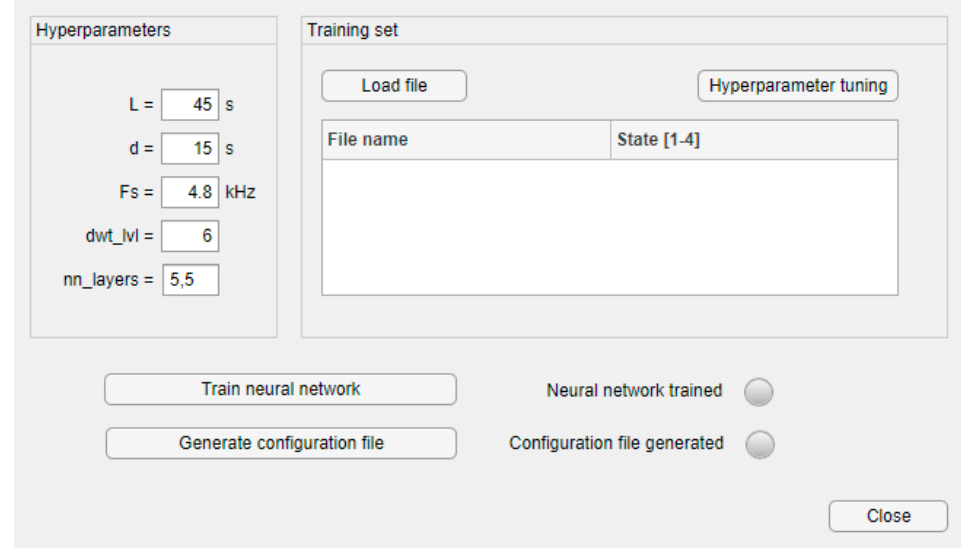
Figure 5. Graphical user interface of FASTER configuration software.